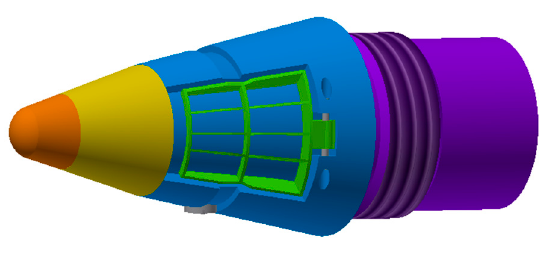
Figure 1. Appearance of the trajectory correction fuze.